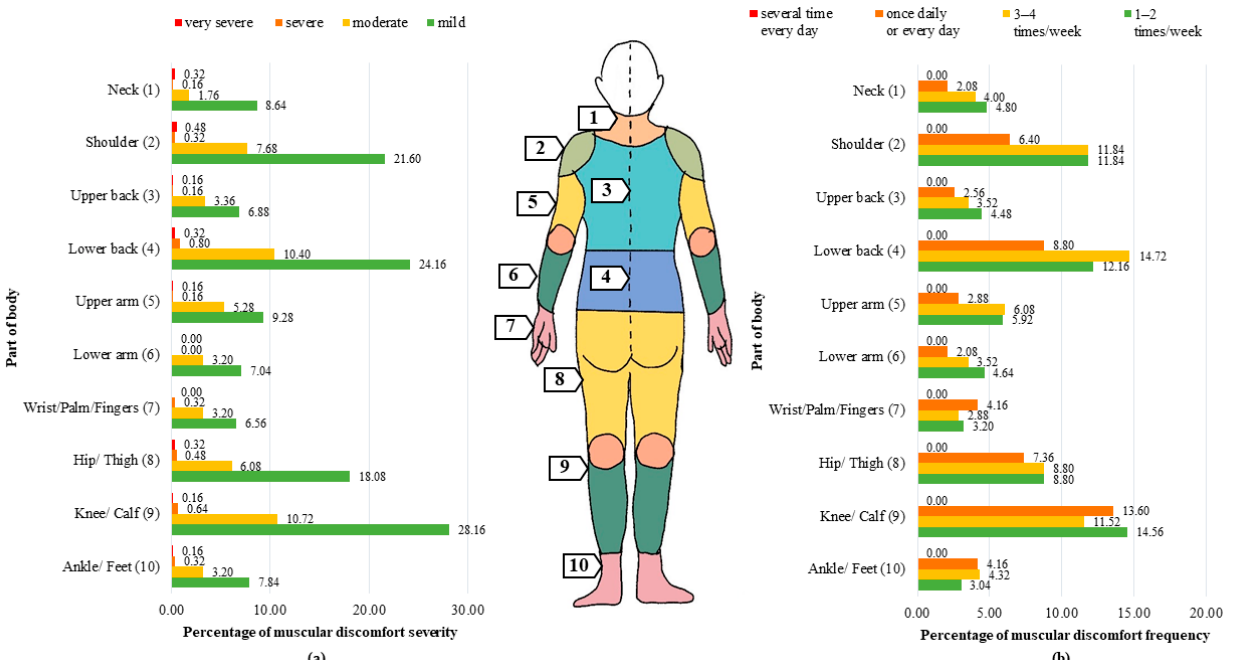
Figure 1. The percentages of ( a ) severity and ( b ) frequency of muscular discomfort classified accord- ing to parts of the body.